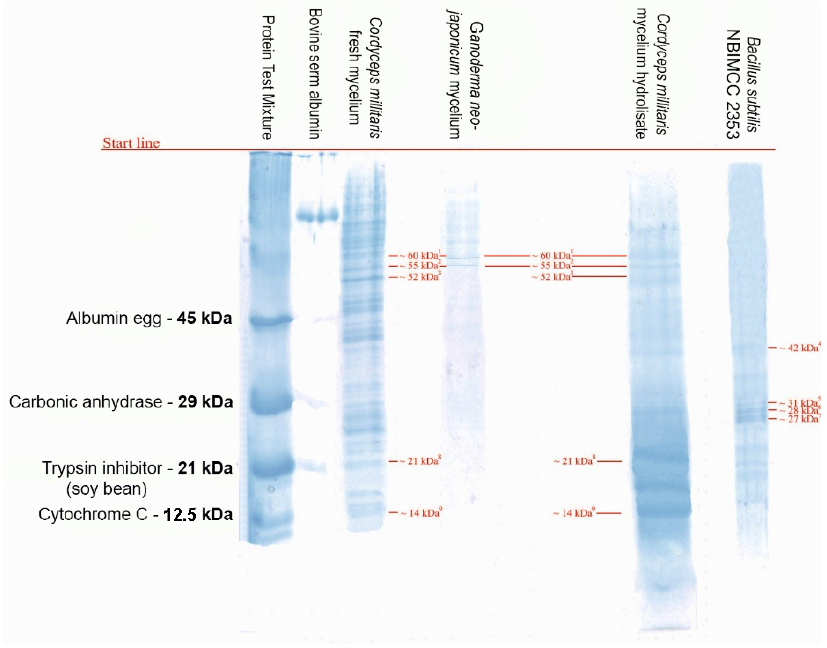
Figure 2. Polyacrylamide gel electrophoresis of medicinal mushroom samples of Cordyceps millitaris (fresh mycelium (1) and hydrolysate (2), Ganoderma neo-japonicum (fresh mycelium (3)) and Bacillus subtilis NBIMCC 2353 (8) cultured strain sample. Test mixture of proteins of known molecular weight and Bovine serum albumin (66.4 kDA) were used as a standard.